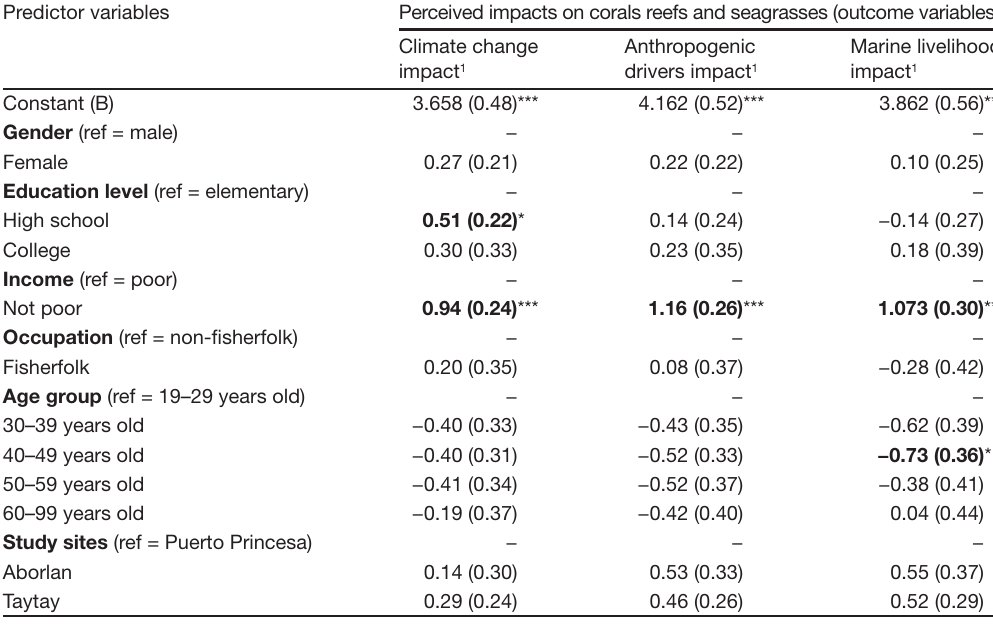
Table 5. Results of linear regression analysis predicting the participants’ risk perceptions of climate change impact, anthropogenic pressures and marine livelihood from key socio- demographic characteristics in the coastal marine environment of Palawan, Philippines (standard error in parenthesis) Predictor